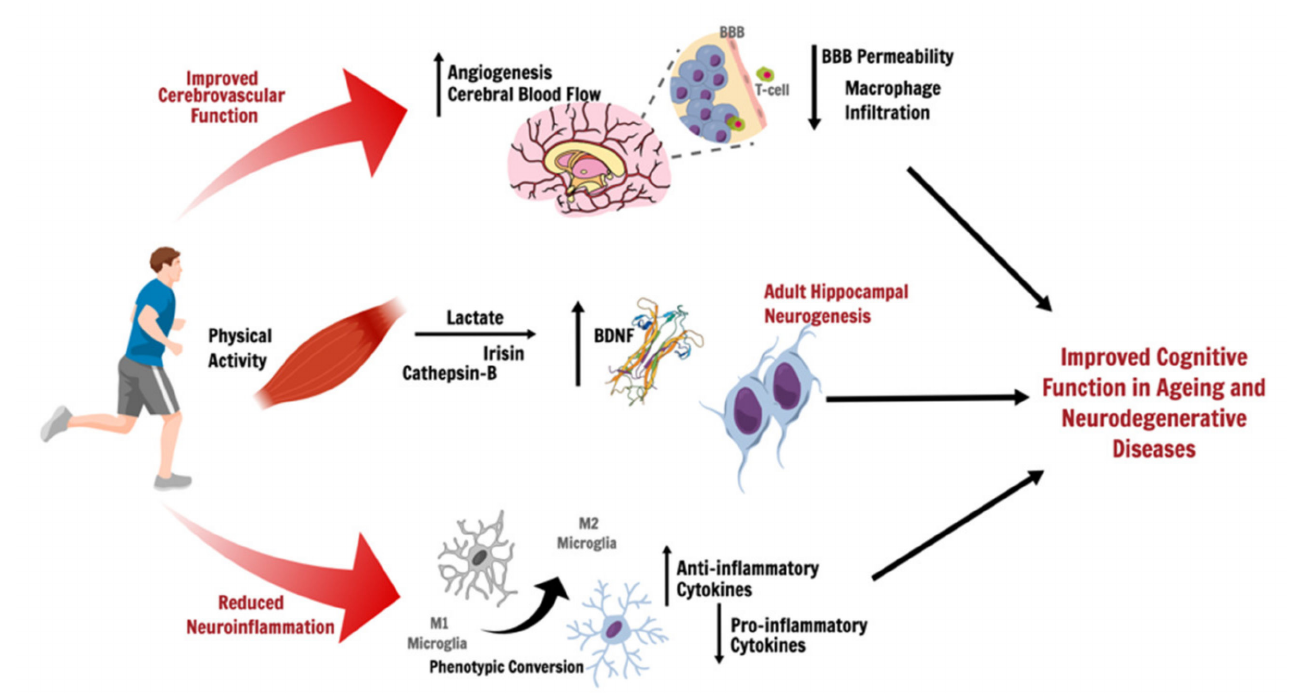
Figure 1. Mechanisms mediating the beneficial effects of exercise on brain health. Physical activity improves cognitive function in ageing and neurodegenerative diseases by improving cerebrovascular function, reducing neuroinflammation, and promoting adult hippocampal neurogenesis. Figure created using BioRender